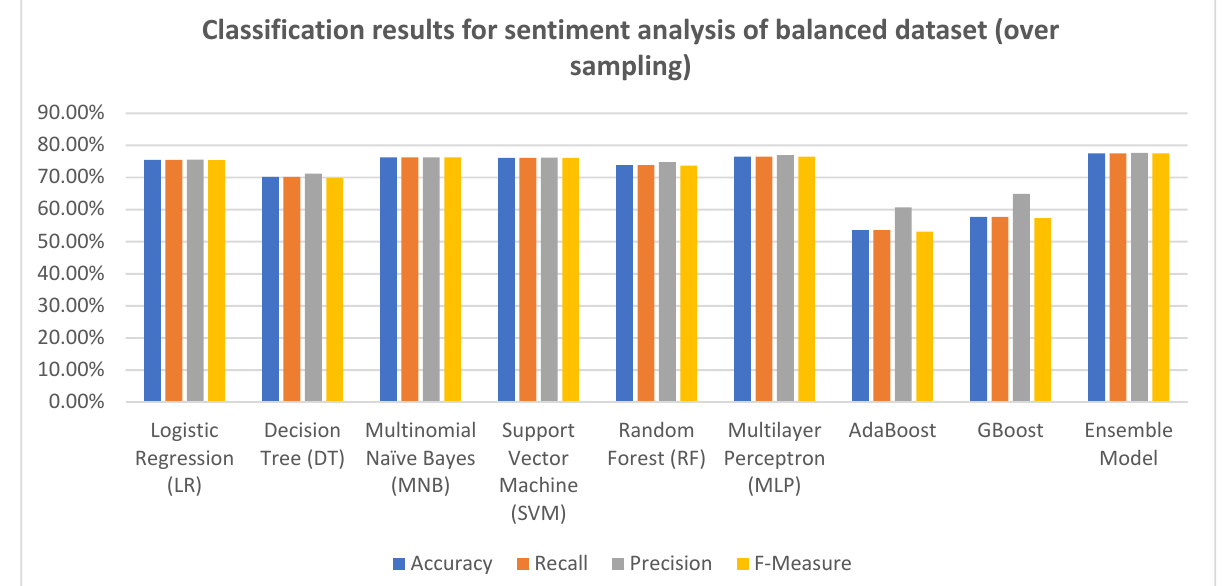
Figure 6. Classification results for sentiment analysis of balanced dataset (oversampling).